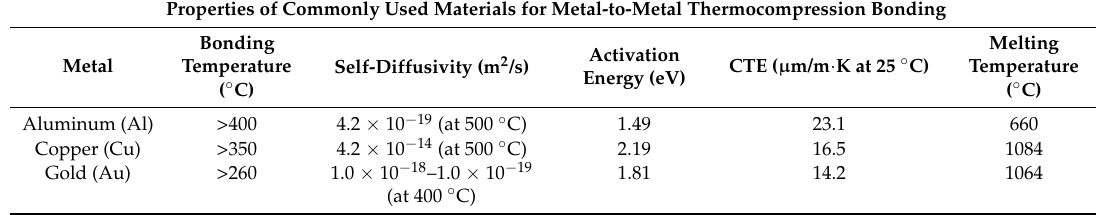
Table 7. Properties of metals used in metal thermocompression bonding [166,167].